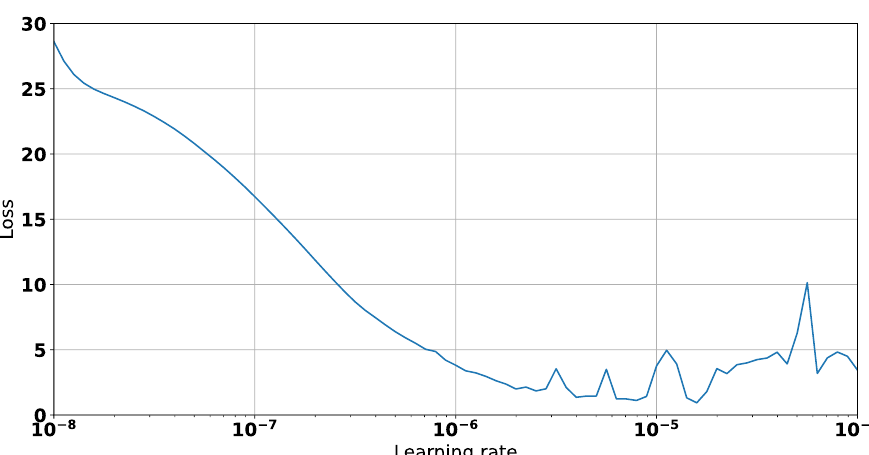
Figure 6. Learning rate schedule output—LSTM.